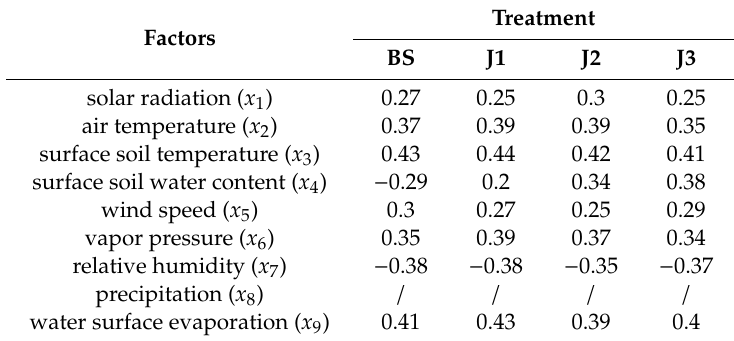
Table 3. Weight coefficients of factors in F1 during the unstable freezing stage (P1). Table 3. Weight coe ffi cients of factors in F1 during the unstable freezing stage